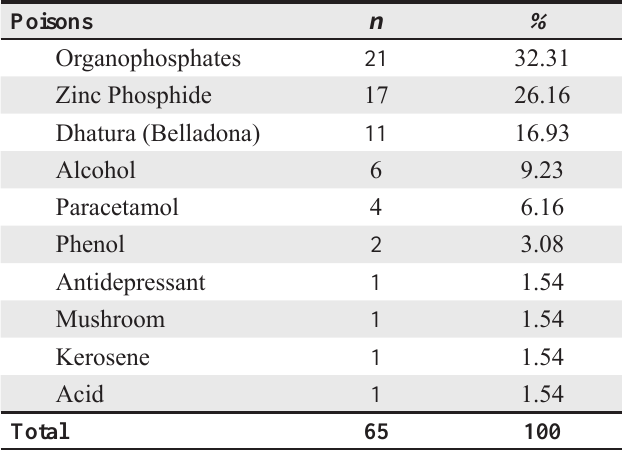
Table 3 : Types of poison